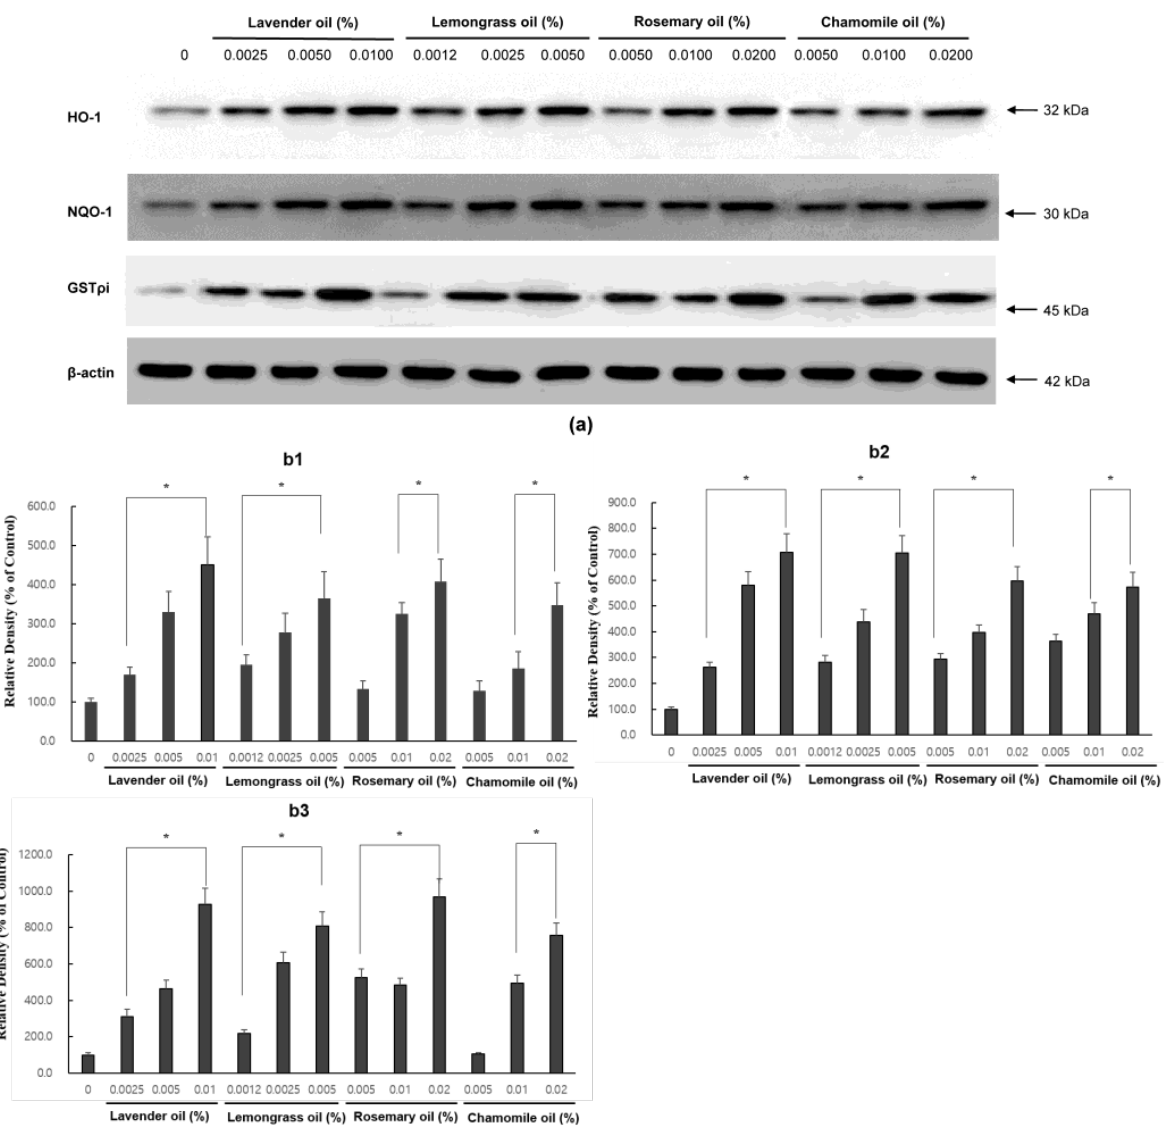
Figure 5. Dose-dependent induction of the protein expression of phase II enzymes measured by Western immunoblots in essential oils-treated DPC. ( a ) The DPCs were treated with lavender oil (0.025% – 0.01%), lemongrass oil (0.0012% – 0.005%), rosemary oil (0.005% – 0.02%), and chamomile oil (0.005% – 0.02%). The figure shows representative results of triplicate experiments. ( b ) Phase II en- zymes protein level are quantified by densitometric analysis * p < 0.05.